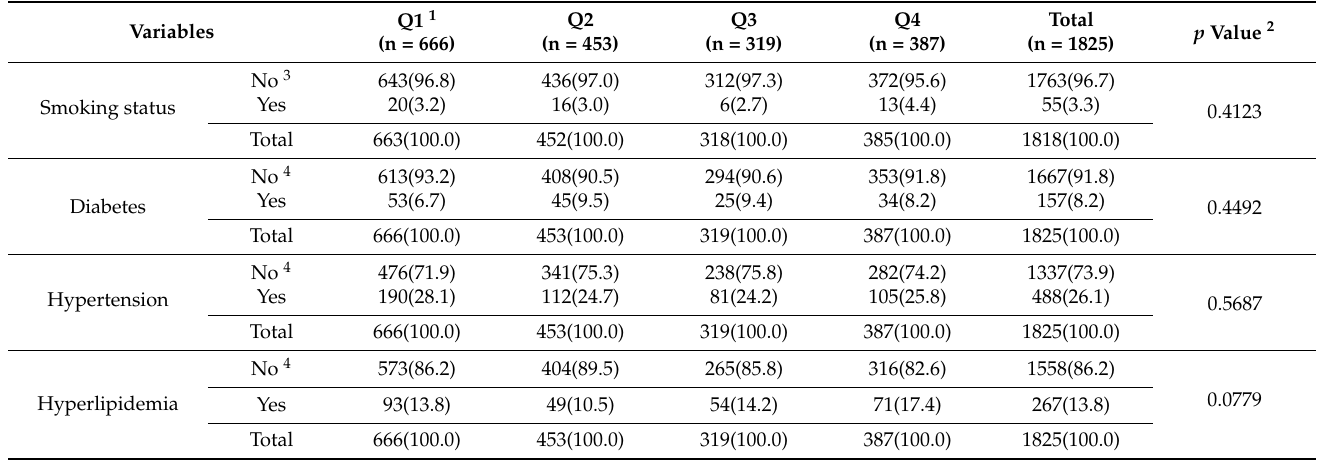
Table 4. Smoking status and disease fraction (%) according to cow’s milk consumption frequency (N